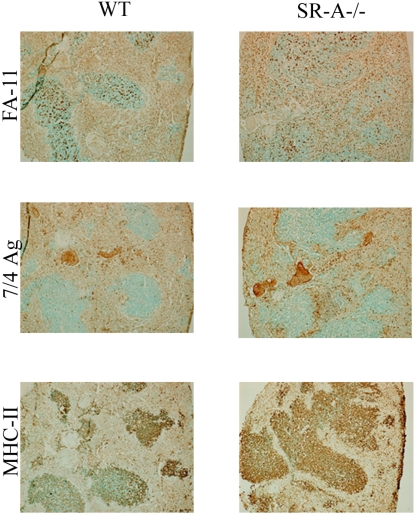
Intact spleen segments from infected animals were fixed in paraformaldehyde, embedded in OCT, sectioned, and stained with various antibodies for the infiltration of macrophages (FA-11), polymorphonuclear neutrophils, and activated monocytes (7/4Ag) and activated macrophages (MHC-II), as described in the text.All data are representative of at least three individual experiments.